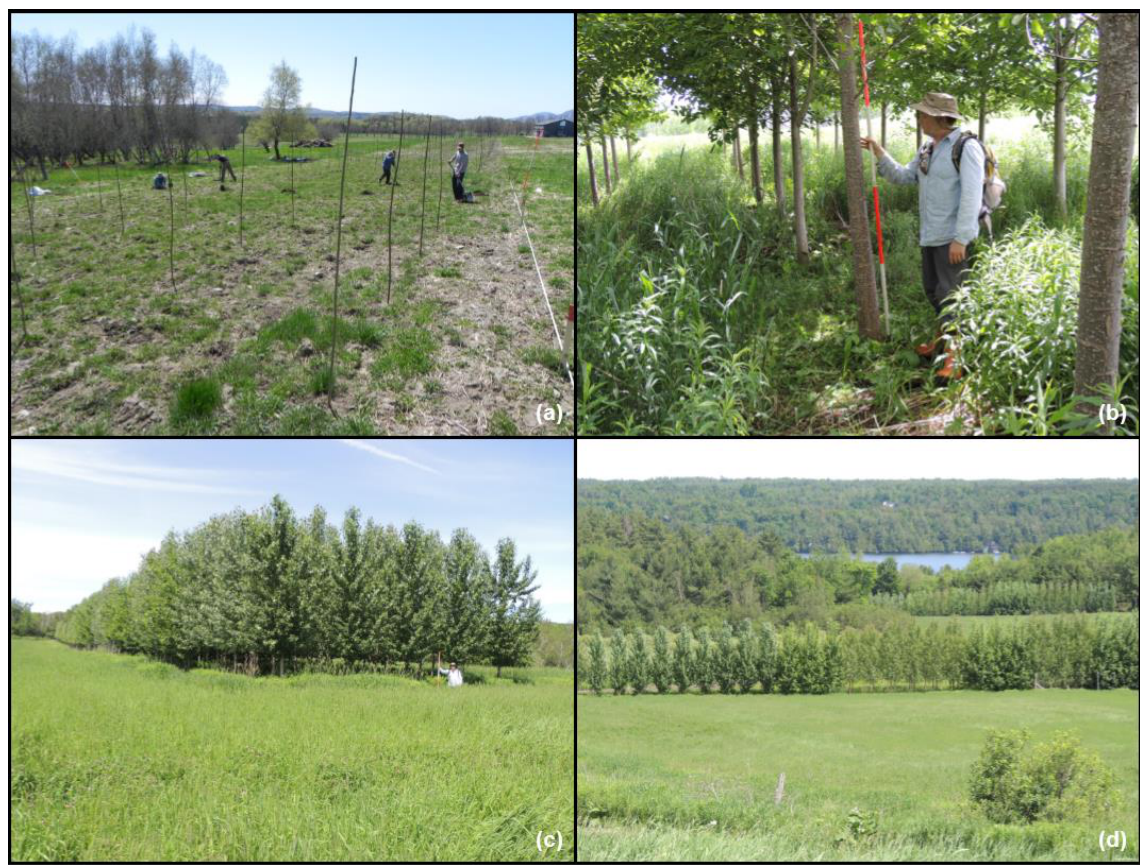
Figure 7. Intensive production zones composed of five rows wide hybrid poplar field-margin buffers ( a ) during their establishment on the lower slope edges of Abbey fields in May 2011; and ( b , c ) at the beginning of the fifth growing season in June 2015; ( d ) landscape perspective of poplar field-margin buffers located upslope from Lake Memphremagog (June